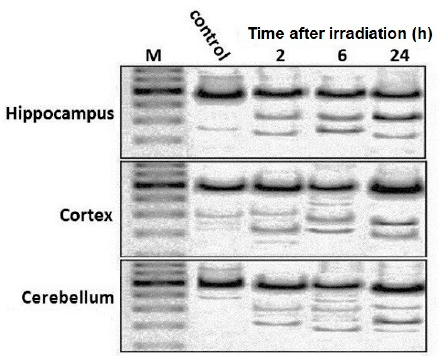
Figure 3. Electrophoresis of cleavage products obtained by Surveyor nucleases digestion of heteroduplexes of mtDNA PCR amplicons from the different rat brain regions at 2, 6, and 24 h after irradiation.